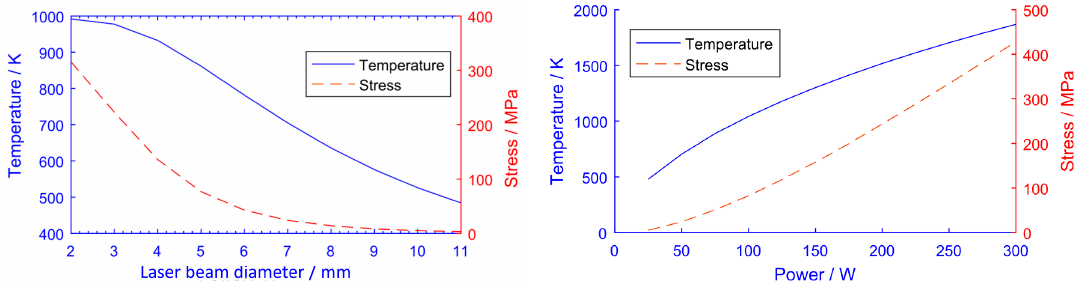
Figure 6. Simulated temperature and stress after 10 s irradiation as a function of laser beam diameter for a 50 W laser power ( left ) and laser power at a 7 mm beam diameter ( right ).